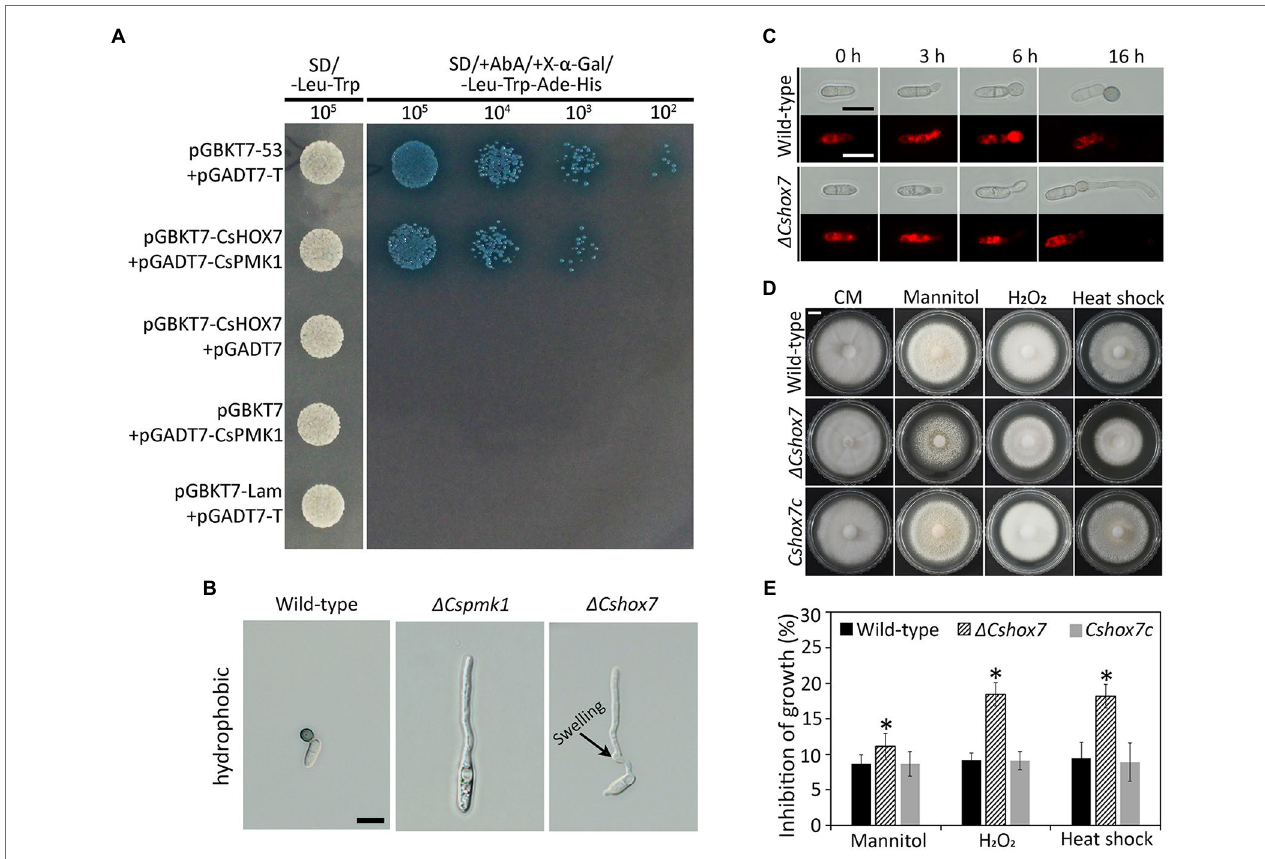
FIGURE 8 | Yeast two-hybrid analysis, appressorium formation assays, lipid mobility, and stress adaption of mycelia. (A) Yeast two-hybrid assay. The control strain expressing pGBKT7-53 and pGADT7-T (control), and a strain expressing pGBKT7-CsHOX7 and pGADT7-CsPMK1 was able to grow on both SD-Leu-Trp and SD/ +Aureobasidin A/+ X- α -Gal/ − / − Leu-Trp-Ade-His. A strain expressing pGBKT7 and pGADT7-CsPMK1, pGBKT7-CsHOX7 and pGADT7, or pGBKT7-Lam and pGADT7-T only grew on SD-Leu-Trp. (B) Appressorium formation assay. Conidia harvested from 7-day-old oatmeal agar (OMA) were placed on the hydrophobic surface of coverslips and incubated at 25 ° C. Both Δ Cspmk1 and Δ Cshox7 failed to form appressoria, but Δ Cshox7 developed swellings in germ tube. Scale bar, 10 μ m. (C) CsHOX7 is related to lipid mobilization during appressorium formation. Conidial suspensions (5 × 10 4 ml − 1 ) were placed on the hydrophobic surface of coverslips and incubated at 25 ° C. Nile red was used to stain lipid droplets during conidial germination and appressorium formation. Scale bar, 10 μ m. (D,E) Mycelial growth of Δ Cshox7 on complete medium agar (CMA) containing chemical stresses. Three-day-old mycelial agar plugs (5 mm in diameter) were inoculated into complete medium agar (CMA) and cultured at 28 ° C, or on CMA containing 1 M mannitol and 5 mM H 2 O 2 . (D) Photographs were taken after 6 days. Scale bar, 1